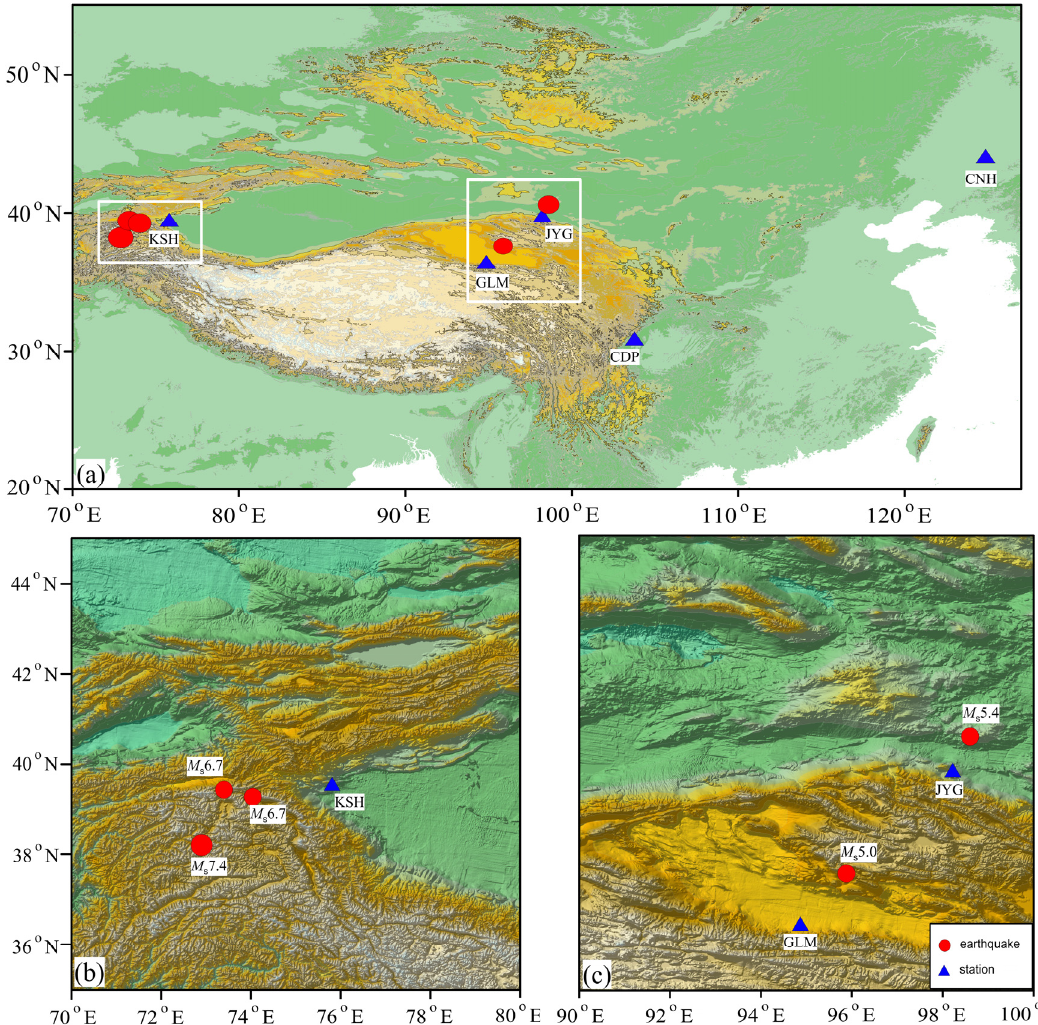
Figure 1. Distribution of geomagnetic stations and earthquakes at ( a ) the national scale, ( b ) KSH area, ( c ) JYG and GLM area.